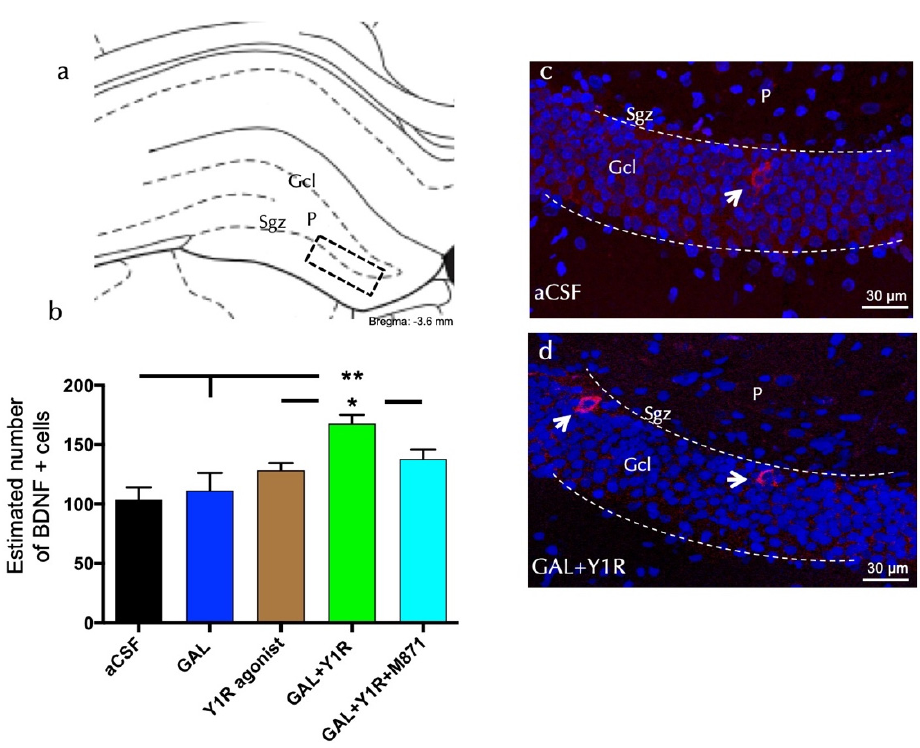
Figure 2. Galanin and the Y1R agonist effects on hippocampal brain-derived neurotrophic factor- immunoreactive (BDNF-IR) cells of the dentate gyrus (DG) hippocampal region. ( a ) BDNF-IR cells were located mainly in the sub-granular zone (Sgz) of the dentate gyrus at the border of the granular cell layer (Gcl), and some scattered cells were found in the polymorphic layer (P) of the dentate gyrus in the dorsal hippocampus (Bregma: –3.6 mm, according to the Paxinos and Watson [33] ste- reotaxic atlas). ( b ) Quantitative morphometric analysis of BDNF-IR cells of the DG. GAL and Y1R agonist icv co-administration significantly increased BDNF-IR cells in the dorsal DG. This effect was counteracted in the presence of the GALR2 antagonist M871. * p < 0.05 vs. Y1R agonist and GAL + Y1R + M871; ** p < 0.01 vs. aCSF and GAL according to one-way ANOVA followed by Newman– Keuls post-hoc test. The vertical lines from the horizontal line above the bars indicate the inter- group comparisons. Data are expressed as mean ± SEM, n = 4. Statistical values are presented in Supplementary Table S1. ( c , d ) Representative microphotographs of the significant increment in the BDNF-positive cells in the DG after GAL and Y1R agonist co-injection ( d ) compared with the control group ( c ). The cells in red are BDNF-positive using confocal laser microscopy. White arrows point to BDNF-IR cells. Dashed lines outline the Gcl of the dentate gyrus. The nuclei are shown in blue by DAPI. Abbreviations: aCSF = Control (artificial cerebrospinal fluid), GAL = galanin (3 nmol), Y1R agonist = Y1R receptor agonist [Leu 31 , Pro 34 ]NPY (3 nmol), GAL + Y1R = co-administration of GAL and Y1R, GAL + Y1R + M871 = co-administration of GAL, Y1R, and GALR2 antagonist M871 (3 nmol). Bcl-2-positive cells were explicitly found in the sgz of the dorsal DG (Figure 3a). Quantification of Bcl-2 cells lacked effects after GAL or the Y1R agonist alone compared to the control (Figure 3b). However, the co-injection of GAL and the YR1 agonist signifi- cantly increased (one-way ANOVA, F4, 15 = 4.76, p < 0.05) the number of Bcl-2-positive cells in the dorsal hippocampal DG (Figure 3b, d) compared to GAL, YR1 agonist, or aCSF groups (Newman–Keuls post-hoc test: p < 0.05) (Figure 3a–d). Similar to the BDNF-IR pro- file’s response described above, the presence of the GALR2 antagonist M871 completely blocked this increase (Newman–Keuls post-hoc test: p < 0.05) (Figure 3b), demonstrating the involvement of GALR2 in this interaction. Statistical values are presented in Supple- mentary Table S1.